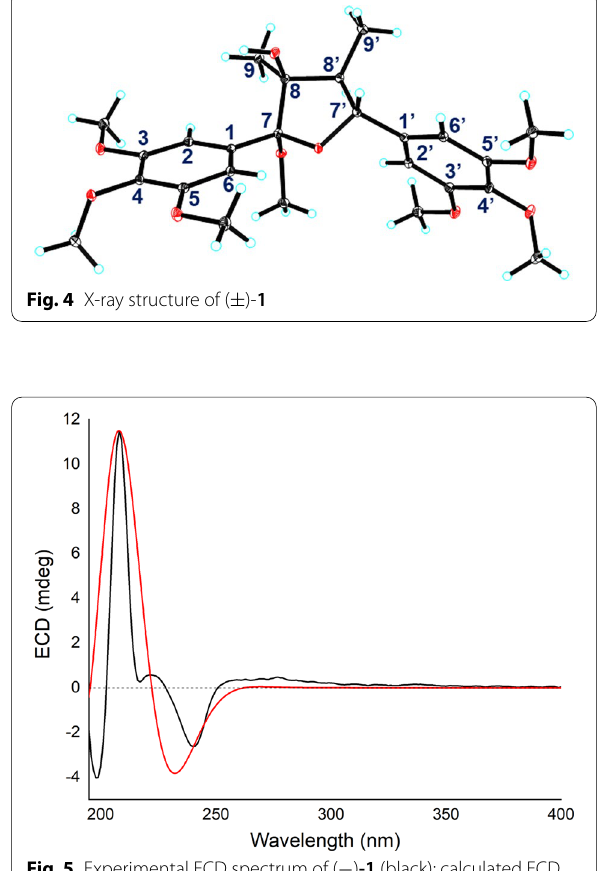
Fig. 5 Experimental ECD spectrum of ( spectrum of (7 S ,8 S ,7 ′ S ,8 ′ R )‑ 1 (shift